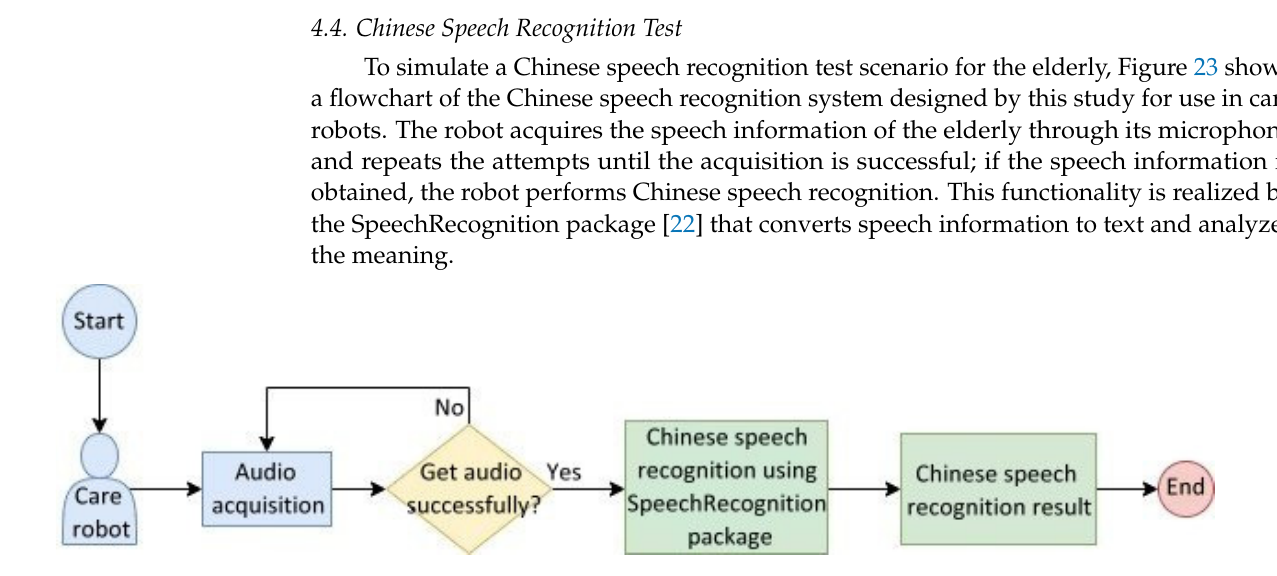
Figure 23. Flowchart of the Chinese speech recognition system embedded in care robots.